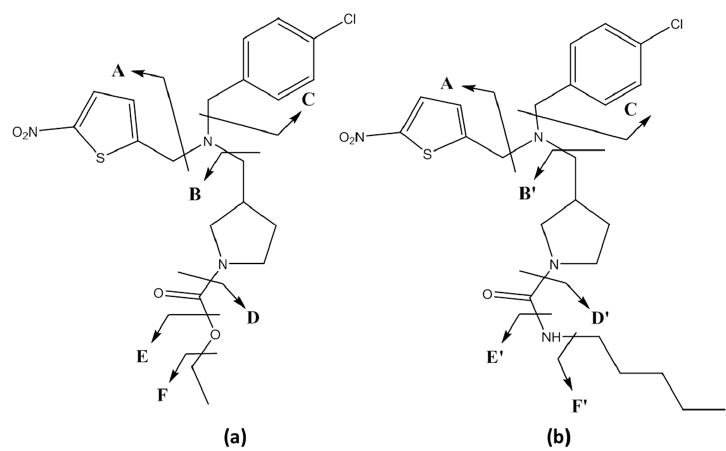
Figure 1. Chemical structures of REV-ERB α agonists SR9009 ( a ) and SR9011 ( b ). The tentative fragmentation patterns are also indicated (by the arrows and the parts of the molecules were assigned to a letter).